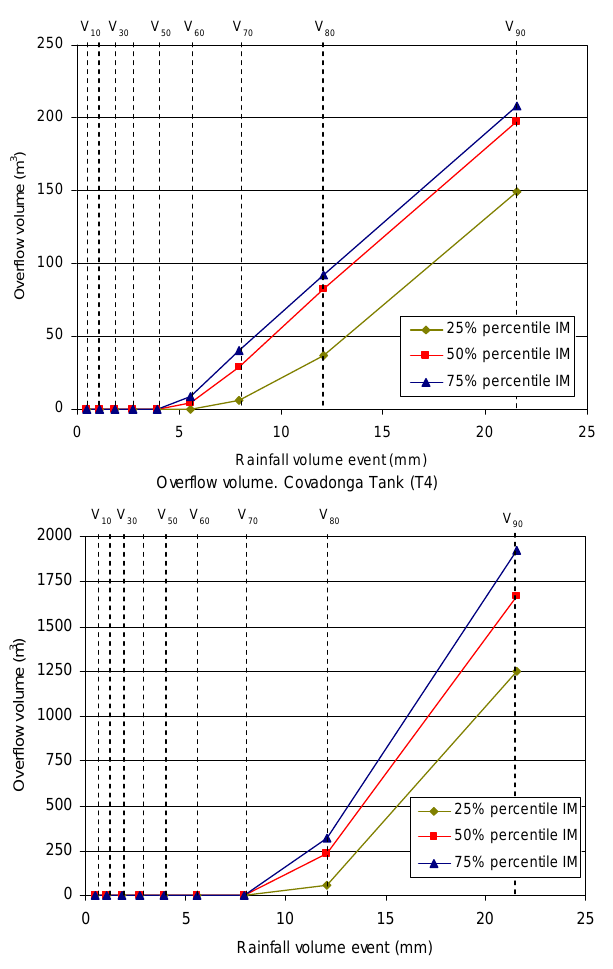
Table 2. Diagnosis results of main storm